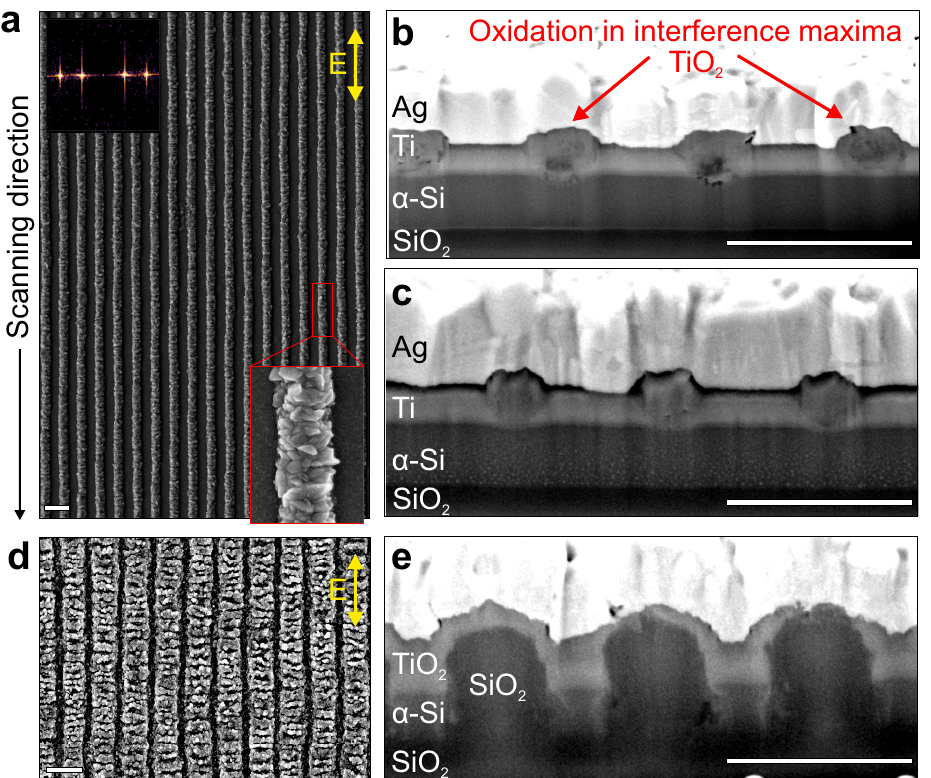
Figure 2. ( a ) Top-view SEM image of TLIPSS structures produced above the 90-nm thick Ti film in air at λ = 1026 nm, F = 90 mJ/cm 2 and v = 1 µm/s. A double arrow indicates the polarization direction. Top inset provides 2D-DFT image of the corresponding SEM image. Bottom inset shows the enlarged view of the single TiO 2 protrusion revealing its nanocrystalline structure. ( b , c ) SEM images of cross-sectional FIB cuts made perpendicularly to the TLIPSS orientation. Both types of TLIPSS were produced at fixed v = 1 µm/s and laser fluences F = 90 ( b ) and 45 ( c ) mJ/cm 2 . ( d ) Top-view SEM image of TLIPSS structures produced at F = 110 mJ/cm 2 and v = 1 µm/s. ( e ) SEM image of the cross-sectional FIB cuts of the TLIPSS presented in ( d ). Scale bar in the images indicates 1